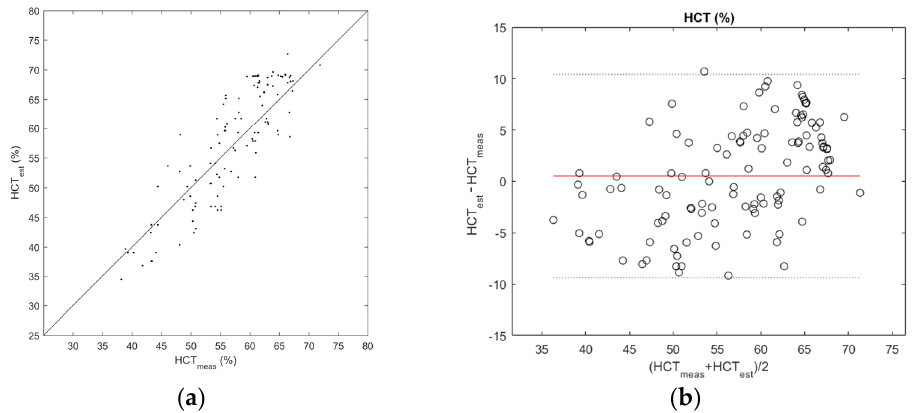
Figure 5. ( a ) Estimated hematocrit vs. measured hematocrit; ( b ) Bland–Altman plot for the estimated hematocrit (HCTest) and measured hematocrit (HCTmeas). The red line indicates the mean difference between the two datasets, and the black dotted lines indicate 95% confidence intervals.